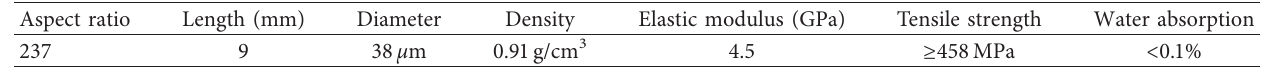
Table 1: Physical properties of polypropylene fiber.